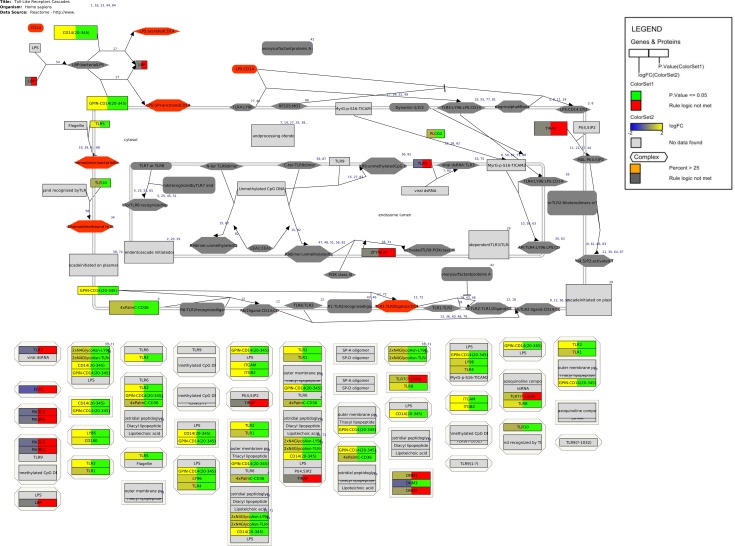
Human granulosa cells gene expression in normal ovulatory versus PCOS women visualized on the Toll-Like Receptors Cascades pathway (WP2775_r83597) in PathVisio [44].Human granulosa cells were isolated from ovarian aspirates of normal ovulatory and PCOS women undergoing IVF. For each sample, RNA was extracted and hybridized to an Affymetrix Gene Chip. Genes not measured appear in gray. The log fold change (logFC) is depicted with a blue to yellow color gradient corresponding to the values -2 to 2. Significant genes with a P.value < 0.05 are marked in green and the rest in red. Significant complexes with a score > 25 are marked in orange and the rest in dark gray.